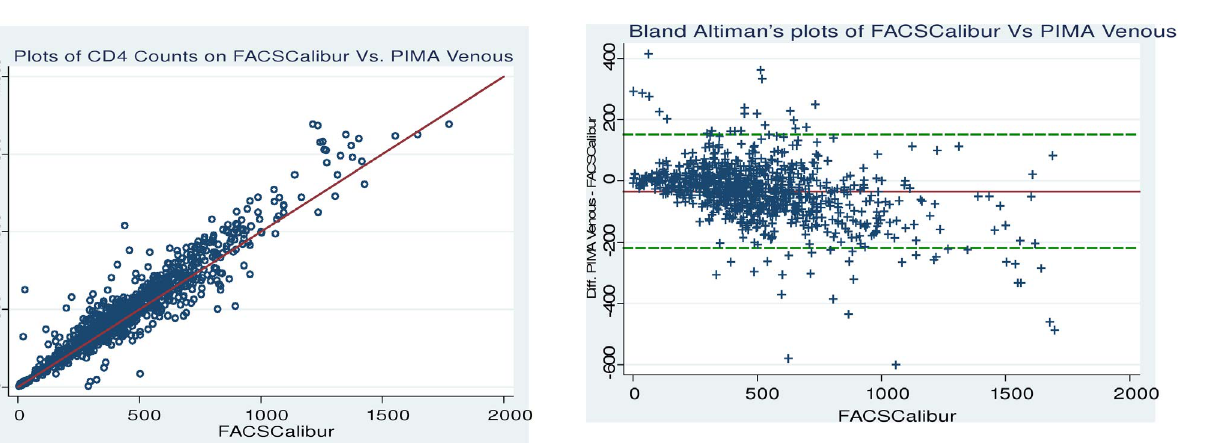
Table 1. Study population characteristics.